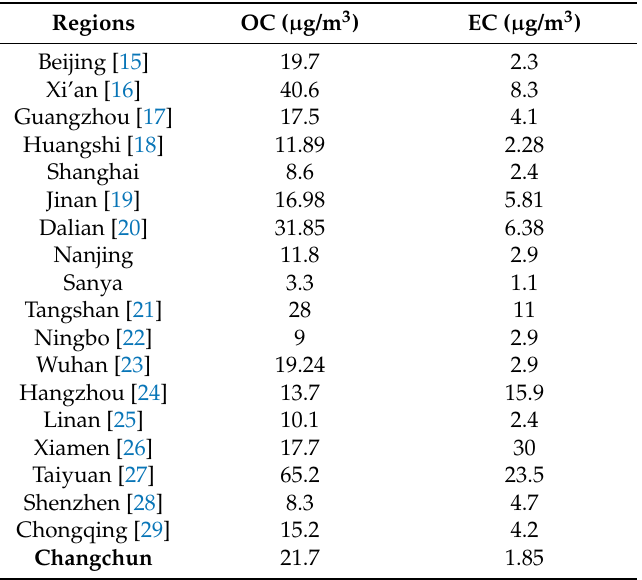
Table 2. Average concentration of organic carbon (OC) and elemental carbon (EC) in PM 2.5 in Changchun and other